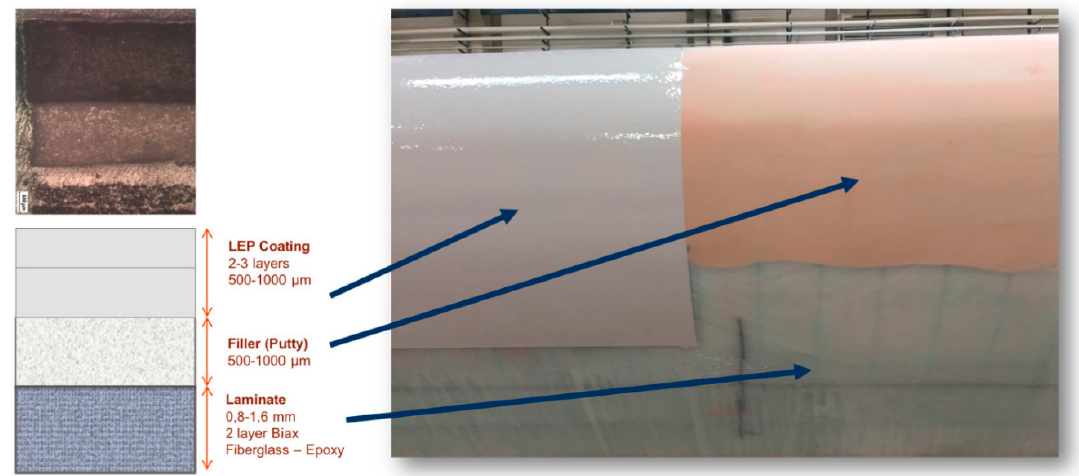
Figure 18. Example of multi-layered Leading Edge Protection System [159].